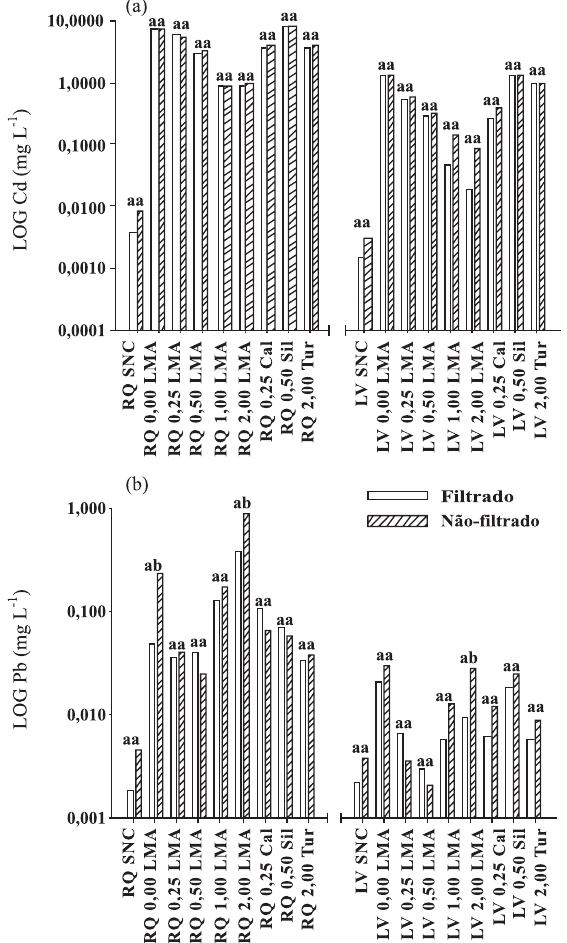
Figura 3. Função logarítmica da concentração de Cd (a) e de Pb (b) (mg L -1 ) nos lixiviados do Neossolo Quartzarênico (RQ) e do Latossolo Vermelho (LV) contaminados com Cd e Pb e coletados no término do experimento. Os resultados se referem a leituras de Cd e de Pb feitas em uma alíquota de lixiviado filtrado em membrana de 0,45 μ m e outra não-filtrada, ambas da mesma parcela. LMA: lama da mineração de Al, SNC: solo não-contaminado, Cal: calcário, Sil: silicato, Tur: turfa, e 0,00; 0,25; 0,50; 1,00 e 2,00: proporção em porcentagem dos amenizantes aplicados correspondendo a 0, 5, 10, 20 e 40 t ha -1 . As barras, dentro de cada tratamento, seguidas de mesma letra não diferem entre si pelo teste de Tukey (p <